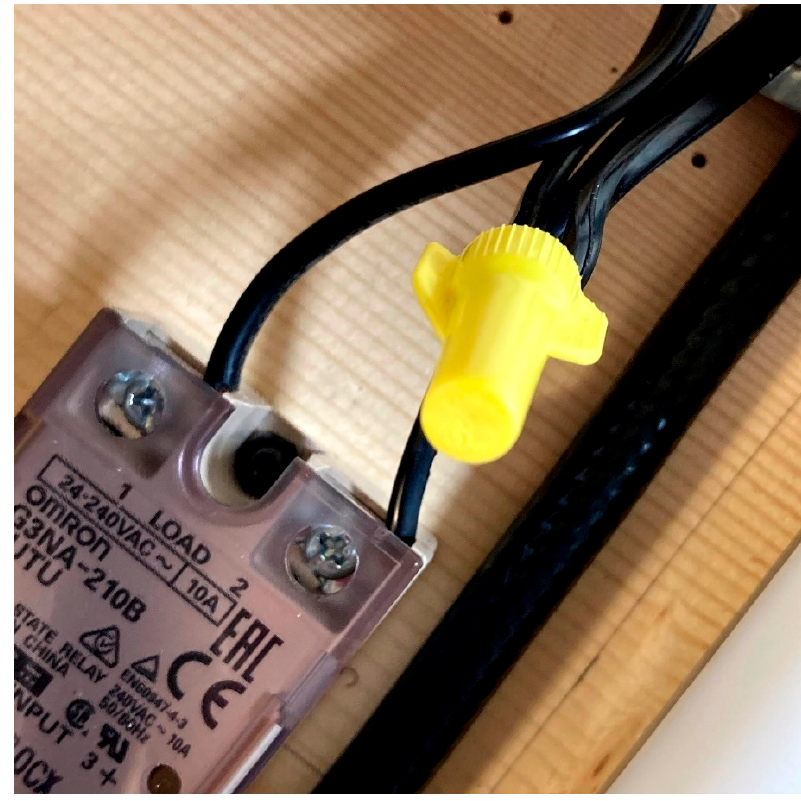
Figure 13. The power cable was secured into the load terminals of the relay.